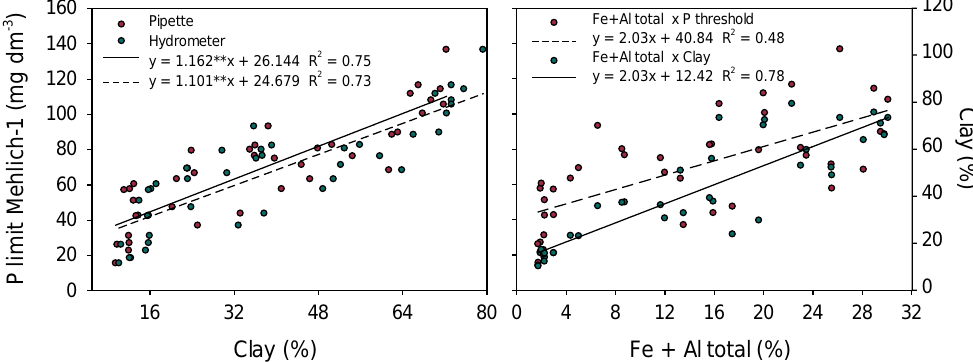
Clay Figure 4. Values of P limit related to the content of clay, using the data of 40 soil samples collected from the state of Rio Grande do Sul, Brazil.